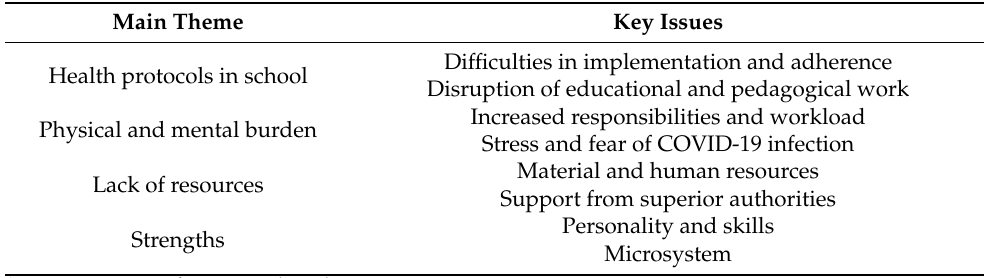
Table 1. Main themes and key issues. Main Theme Key